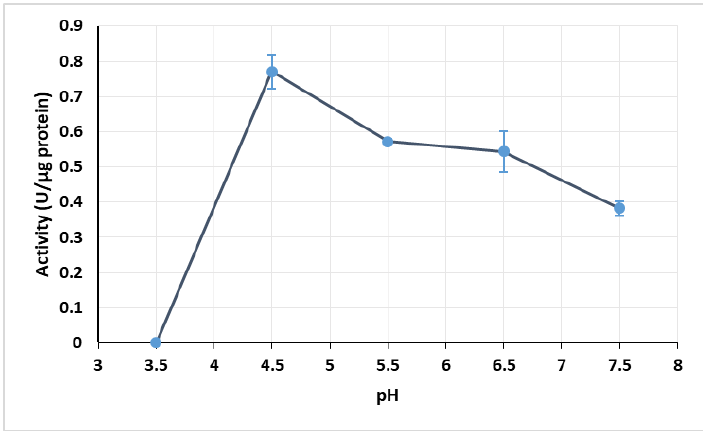
Figure 2. Effect of pH on enzymatic extract activity at 30 °C. Error bars represent standard deviation.